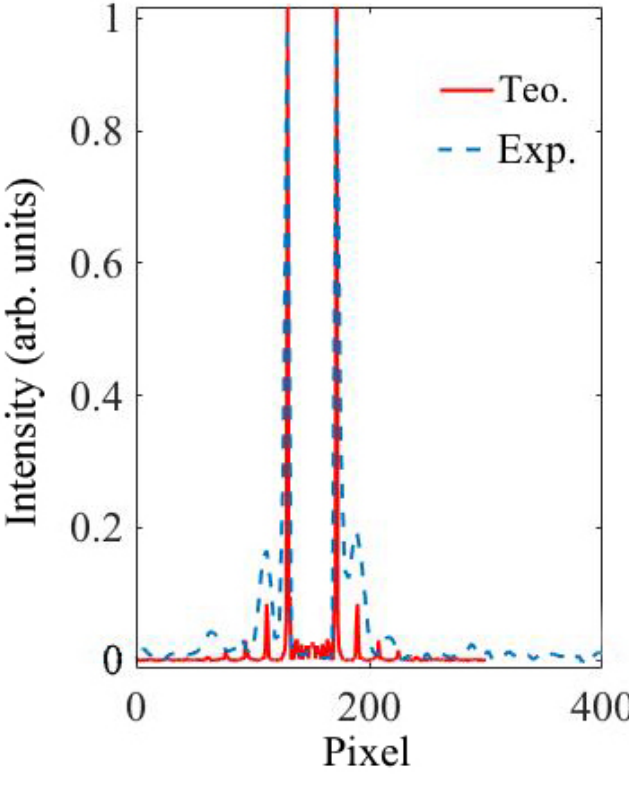
Figure 7. Comparison of intensity measured along a horizontal line of experimental diffraction pattern of diffractive axicon and theoretical intensity obtained through diffraction